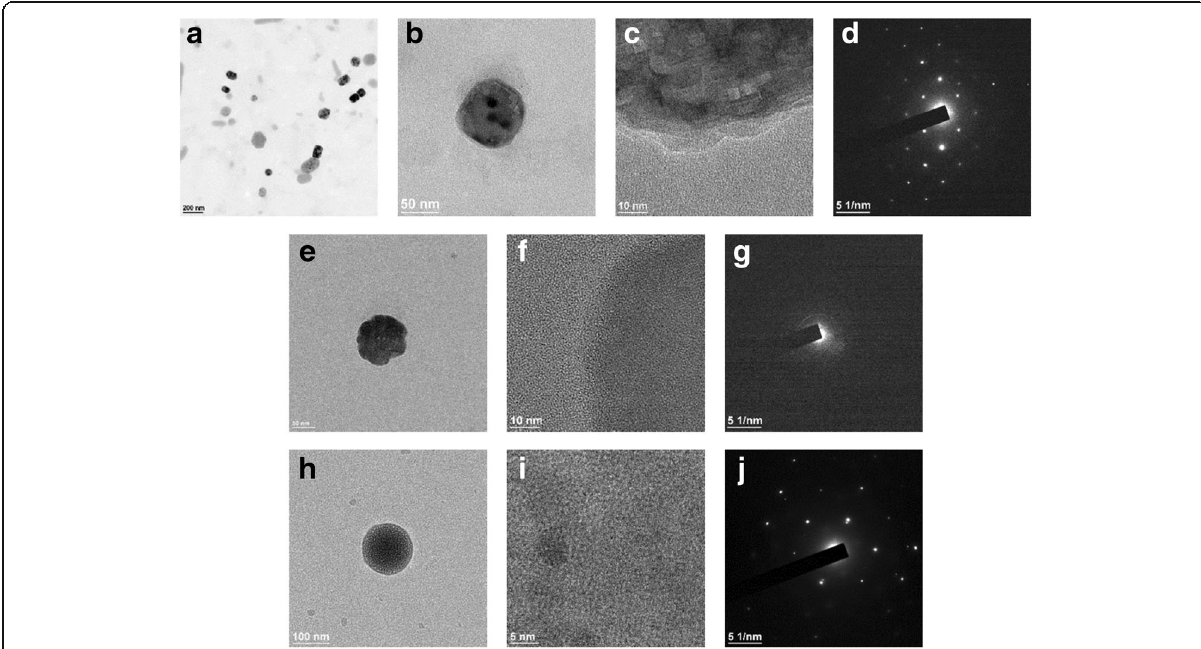
Fig. 6 Transmission electron microscopy (TEM) and selected area electron diffraction (SAED) analyses of dual drug- or single drug-encapsulated nanoliposomes: ERL- and DOX-encapsulated nanoliposomes (scale bar, 200 nm) ( a ), a single nanoliposome containing ERL and DOX-sulfate complexes (scale bar, 50 nm) ( b ), a high resolution- (HR-) TEM image representing DOX-sulfate crystals present inside the nanoliposome and ERL crystals in an outermost region of the nanoliposome (sale bar, 10 nm) ( c ), a SAED pattern of DOX-sulfate crystals and ERL crystals present in a nanoliposome ( d ), a single nanoliposome encapsulated with ERL (scale bar, 50 nm) ( e ), a HR-TEM image representing small crystals of ERL and amorphous domains in an outermost region of the nanoliposome (sale bar, 10 nm) ( f ), a SAED pattern of ERL crystals present in an outermost region of the nanoliposome ( g ), a single nanoliposome encapsulated with DOX (scale bar, 100 nm) ( h ), a HR-TEM image representing crystalline lattices of DOX-sulfate inside the nanoliposome (sale bar, 5 nm) ( i ), and a SAED pattern of DOX-sulfate crystals present inside the nanoliposome ( j